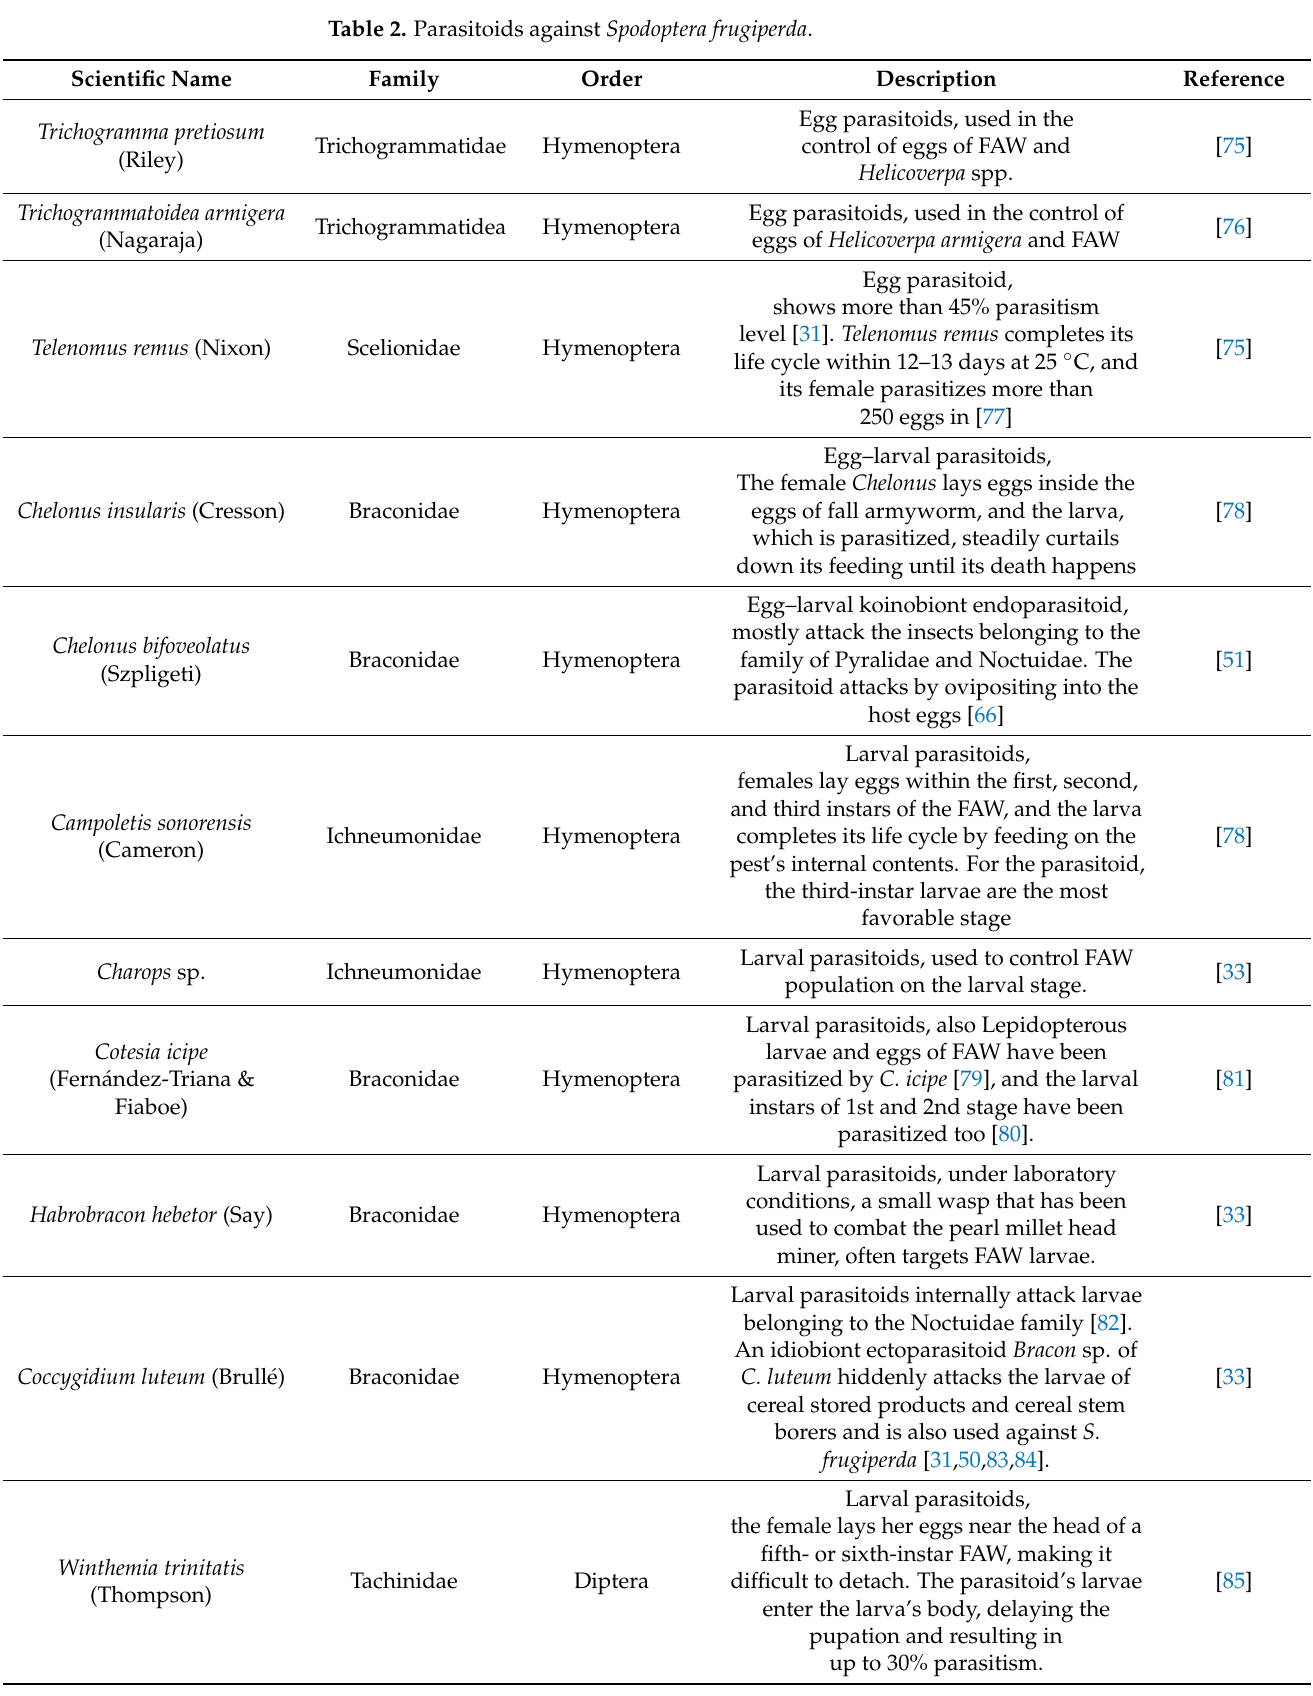
Table 2. Parasitoids against Spodoptera frugiperda